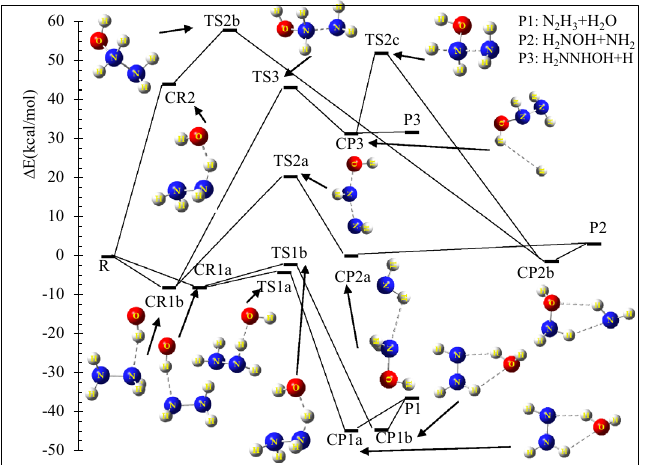
Figure 1. Potential energy profile of the N 2 H 4 + OH reaction for reliable pathways at the CCSD(T)/CBS//MP2/ aTZ